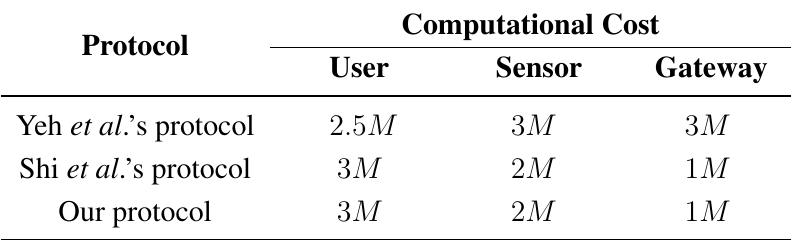
Table 4. Estimated efficiency